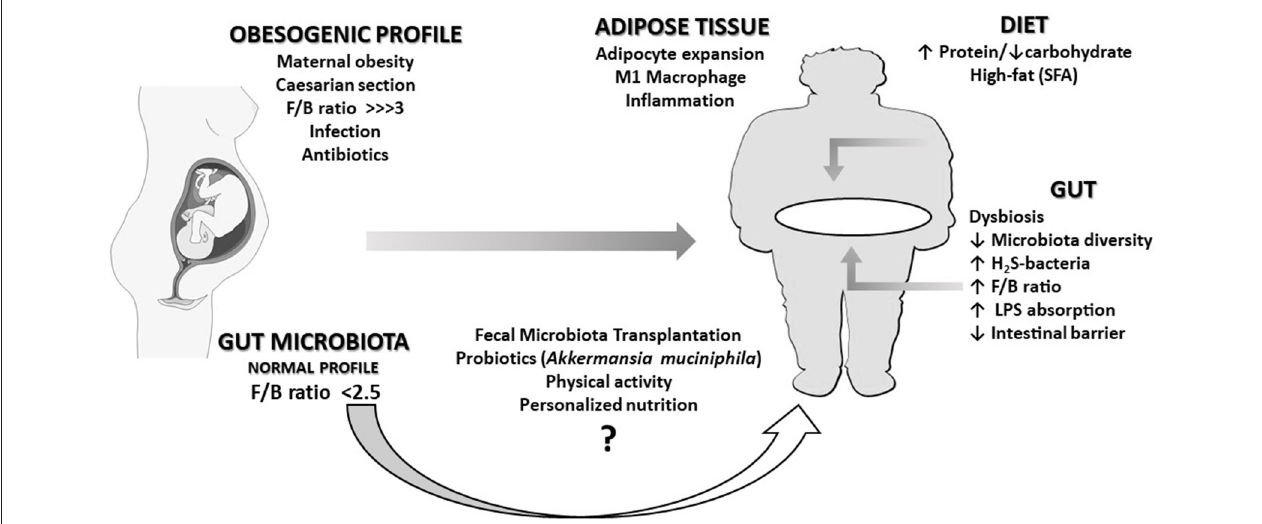
FIGURE 1 | An overview of the relationships described in this opinion paper. An obesogenic profile (characterized by a very high Firmicutes / Bacteroidetes ratio, F/B) can be caused in the fetus by conditions such as maternal obesity, caesarian section, infections, or antibiotics treatments during pregnancy. The immune and pro-inflammatory response caused by intestinal dysbiosis over life can eventually lead the individual to obesity in adulthood. This scenario can be worsened by the chronic intake of a high-fat diet, responsible for the increase of bacteria producing hydrogen disulfide (H 2 S-bacteria) and pathogenic bacterial lipopolysaccharide (LPS) translocation. A healthy dietary pattern and physical activity may contribute to revert dysbiosis. Although probiotics and fecal microbiota transplantation could eventually improve this condition, presently, there is not enough clinical evidence supporting the adoption of such